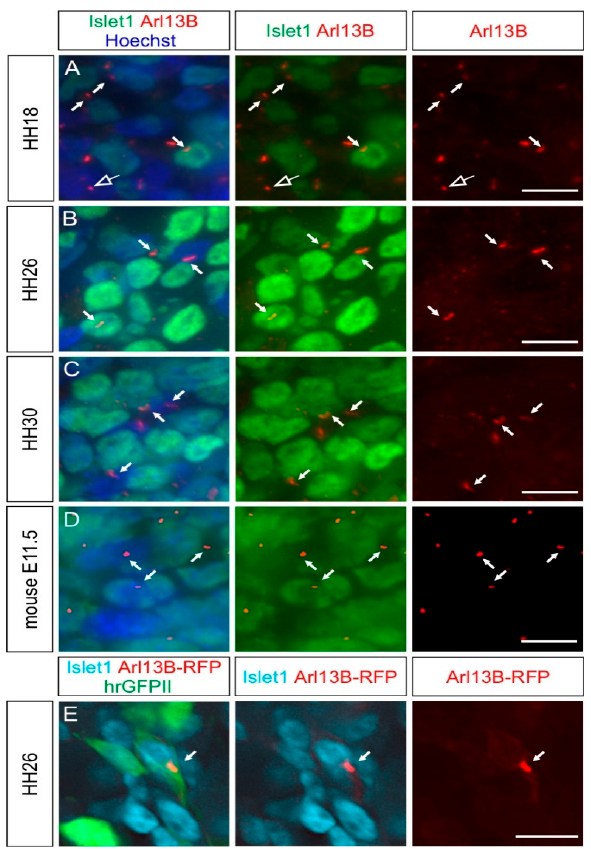
Figure 2. Embryonic DRG neurons possess a primary cilium in chicken and mouse embryos. ( A – D ) Micrographs of Islet1 ‐ positive DRG neurons (green) bearing an Arl13B ‐ positive primary cilium (red, white arrows) at stage HH18, HH26, and HH30. The open arrow points to a primary cilium on an Islet ‐ 1 ‐ negative cell. ( D ) E11.5 mouse DRG neurons also possessed a primary cilium (white ar ‐ rows). Nuclei were counterstained with Hoechst (blue). ( E ) Primary cilia were visible after RFP staining (red) of HH26 Islet ‐ 1 ‐ positive DRG neurons (cyan) after coelectroporation of Arl13B ‐ RFP (white arrow) with hrGFPII (green). Dorsal is up. Scale bars: 10 ( A – D ) and 5 μ m ( E ).